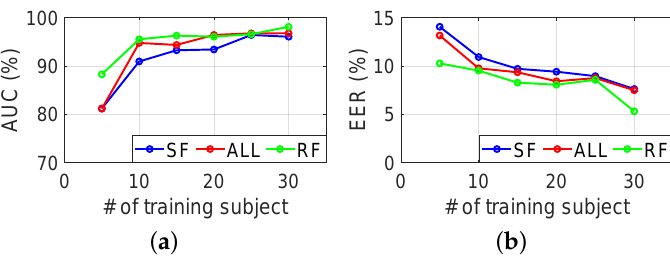
Figure 10. ( a ) AUC and ( b ) EER for different numbers of training subjects.